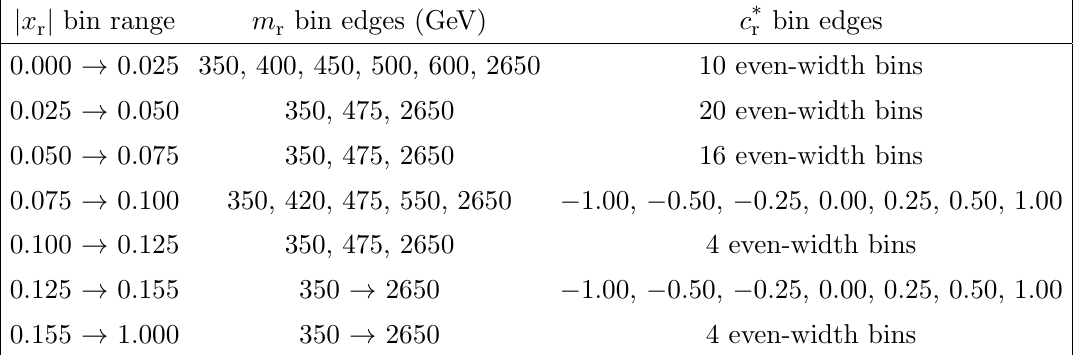
Table 8 . Template binning in the type-3 e+jets signal regions (each template has 164 total bins). Open